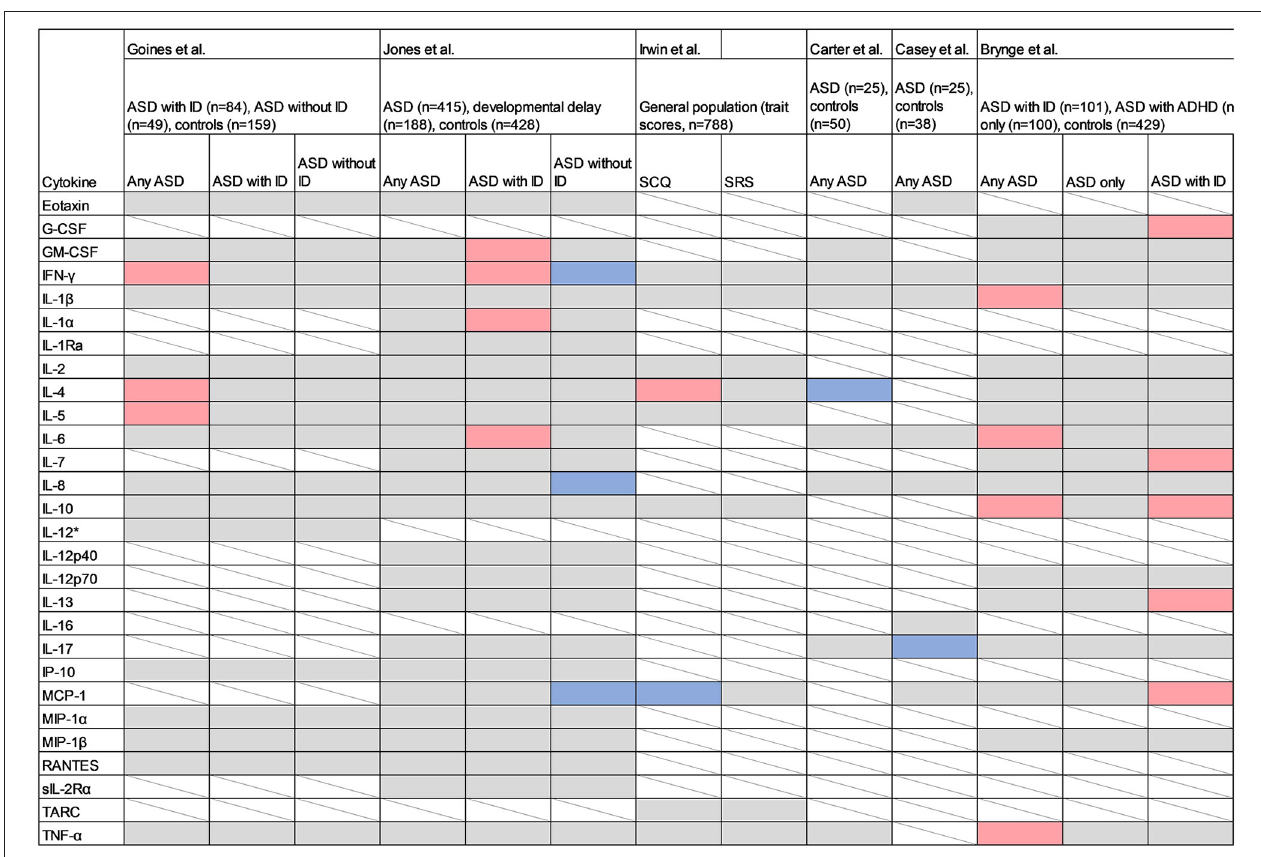
FIGURE 7 | Studies measuring cytokines in maternal serum samples. Red cell color indicates a positive association ( p < 0.05) between the cytokine and the outcome, blue indicates an inverse association, grey indicates no association ( p > 0.05), and white with strikethrough indicates that the cytokine was not measured. SCQ, Social Communication Questionnaire; SRS, Social Responsiveness Scale; IL-1 α , Interleukin 1 α ; IL-1 β , Interleukin 1 β ; IL-2, Interleukin 2; IL-4, Interleukin 4; IL-6, Interleukin 6; IL-7, Interleukin 7; IL-8, Interleukin 8; IL-10, Interleukin 10; IL-12p40, Interleukin 12p40; IL-12p70, Interleukin 12p70; IL-13, Interleukin 13; IL-16, Interleukin 16; IL-17, Interleukin-17; IL-17A, Interleukin-17A; GCSF, Granulocyte Colony-Stimulating Factor; GMCSF, Granulocyte Monocyte Colony-Stimulating Factor; IFN- γ , Interferon- γ ; IP-10, Interferon gamma-induced protein 10; MCP-1, Monocyte Chemoattractant Protein 1; MIP-1 α , Macrophage Inflammatory Protein 1 α ; MIP-1 β , Macrophage Inflammatory Protein 1 β ; RANTES, Regulated on Activation, Normal T-cell Expressed and Secreted; sIL-2R α , Soluble Interleukin 2 Receptor-Alpha; TARC, Thymus and Activation Regulated Chemokine; TNF- α , Tumor Necrosis Factor α